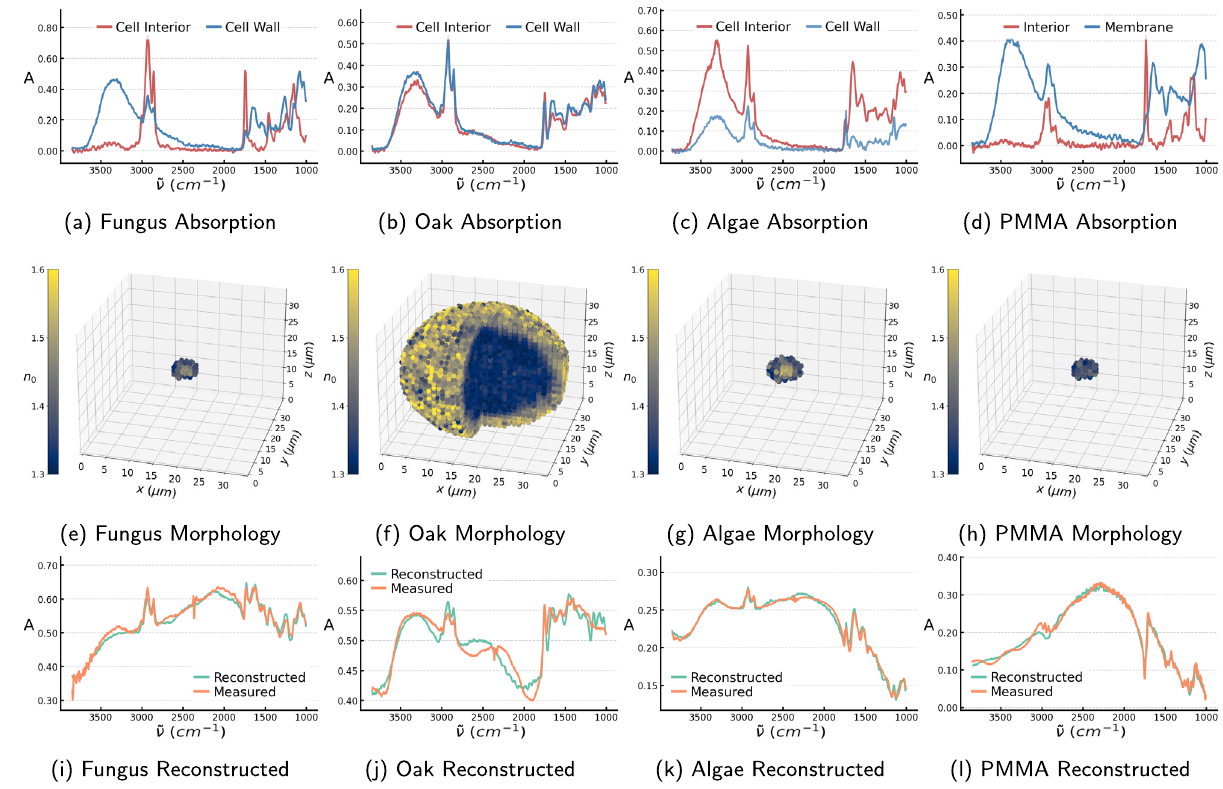
Fig. 3 The ISP-solver was applied to measure the spectra of four different micro-samples. a – d Model predictions of the molecular absorption in the cell wall and the cell interior in samples from fungal cell, oak pollen grain, algal cell, and PMMA sphere. e – h The model ’ s predictions of morphology and distribution of effective refractive index in the samples. i – l Reconstructed spectrum made using the predicted molecular absorption as well as the predicted morphology and refractive indices as input to analytic solutions of Maxwell ’ s equations describing the scattering on concentric spheres. If the predictions are correct, the reconstruction should be very similar to the measured spectrum.